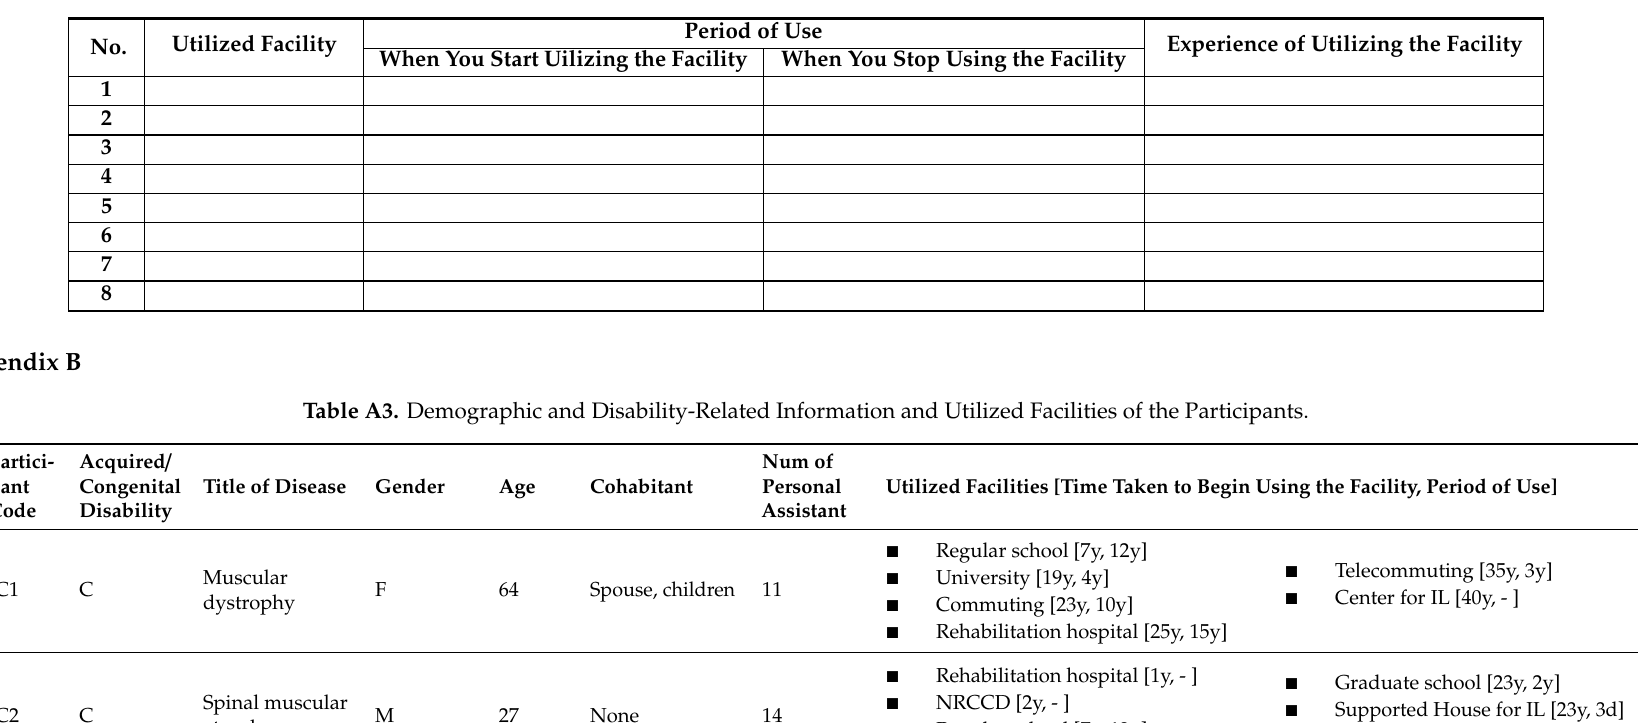
Table A2. Survey Template for Asking Utilized Facilities and Period of Use.